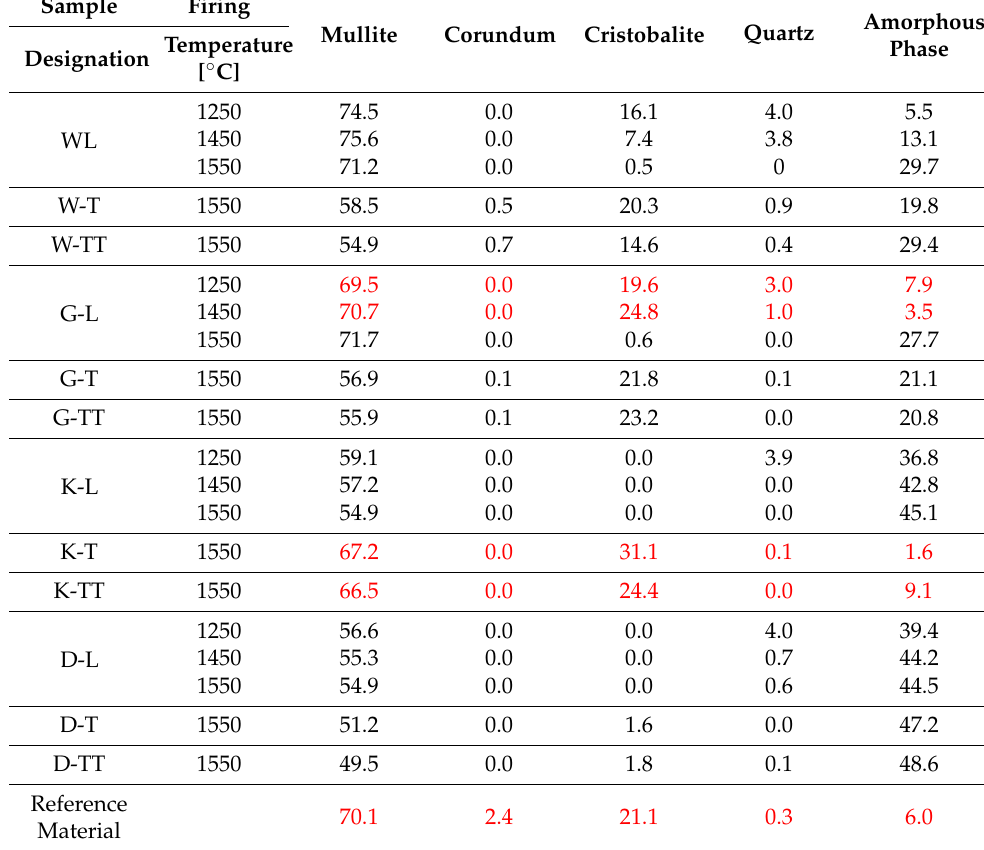
Amorphous Phase Designation Temperature